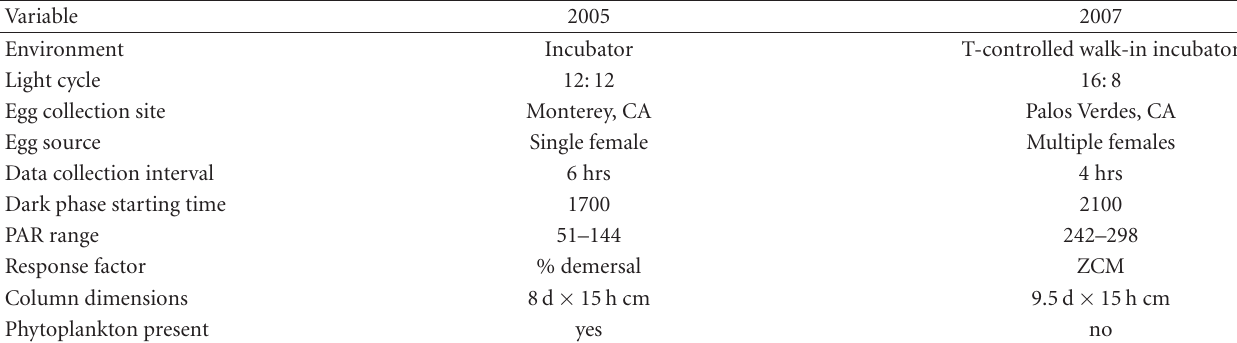
Table 4: Comparison of experimental and control variables in day-night laboratory trials in jars in 2005 versus short columns in